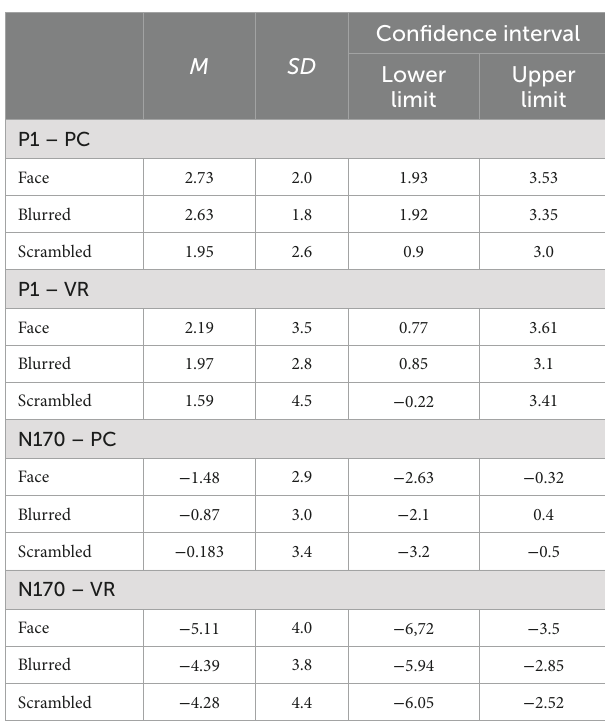
TABLE 1 P1 and N170 mean amplitudes, standard deviations and confidence intervals for both modalities and all stimulus types.